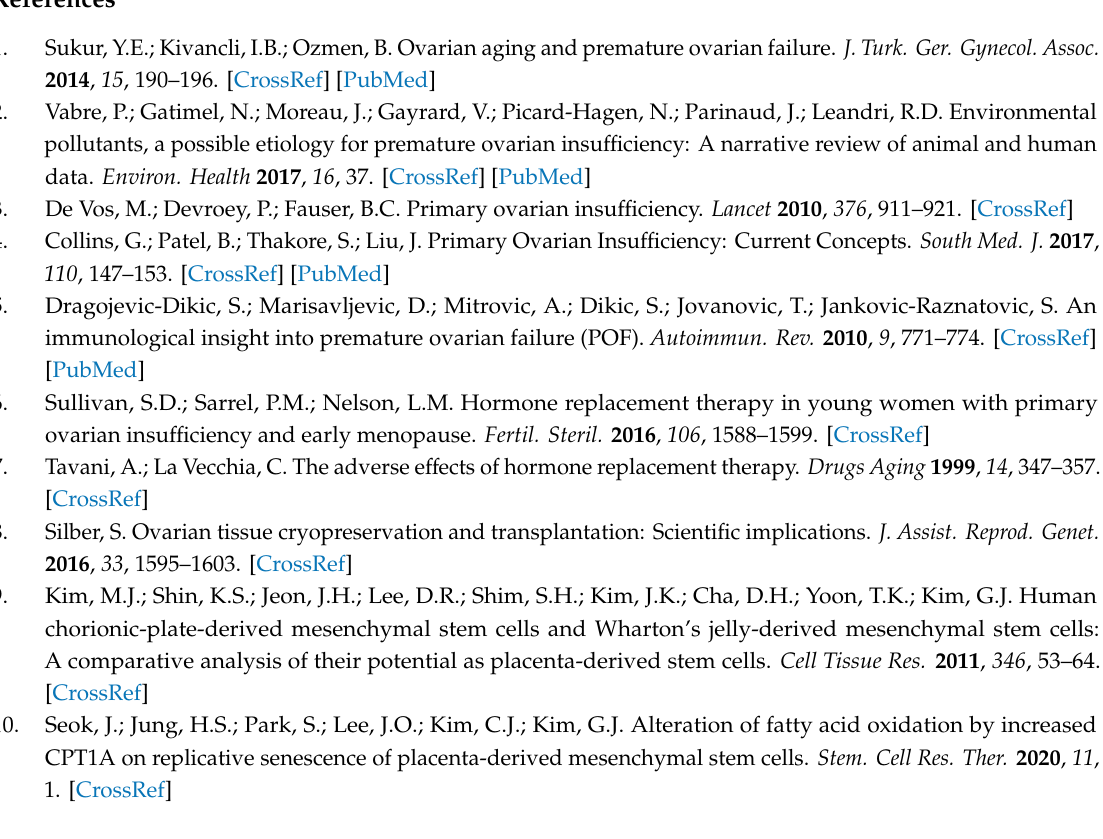
Figure S1: PD-MSCs trigger an upregulated expression of antioxidant enzymes in the exosome of an OVX rat model, Figure S2: E ff ect of PD-MSCs transplantation on gene expression related to folliculogenesis in ovary tissues of OVX